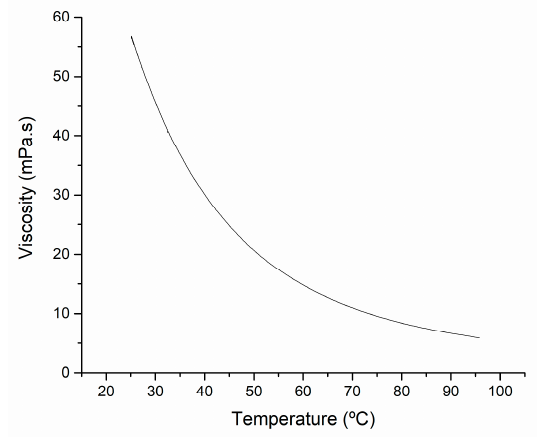
Figure 2. Viscosity–temperature graph for PAO 8 oil.